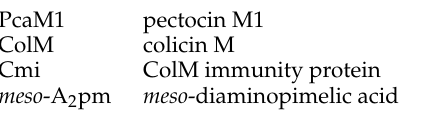
Figure S1: Gel filtration elution profile and SDS-PAGE of the purified wild-type PcaM1 protein; Figure